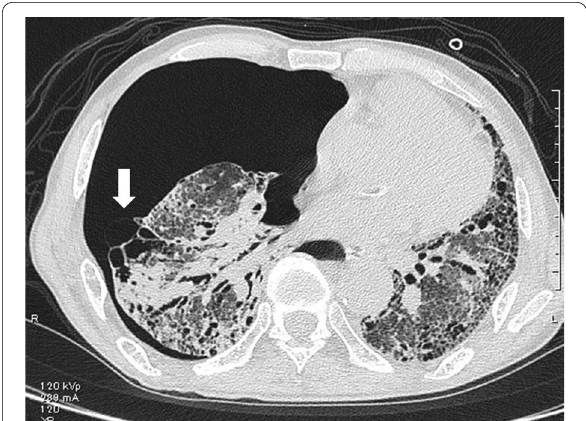
Fig. 1 Computed tomography at the onset of pneumothorax showing cystic lesions in the fissure between the right middle and lower lobes (arrow)